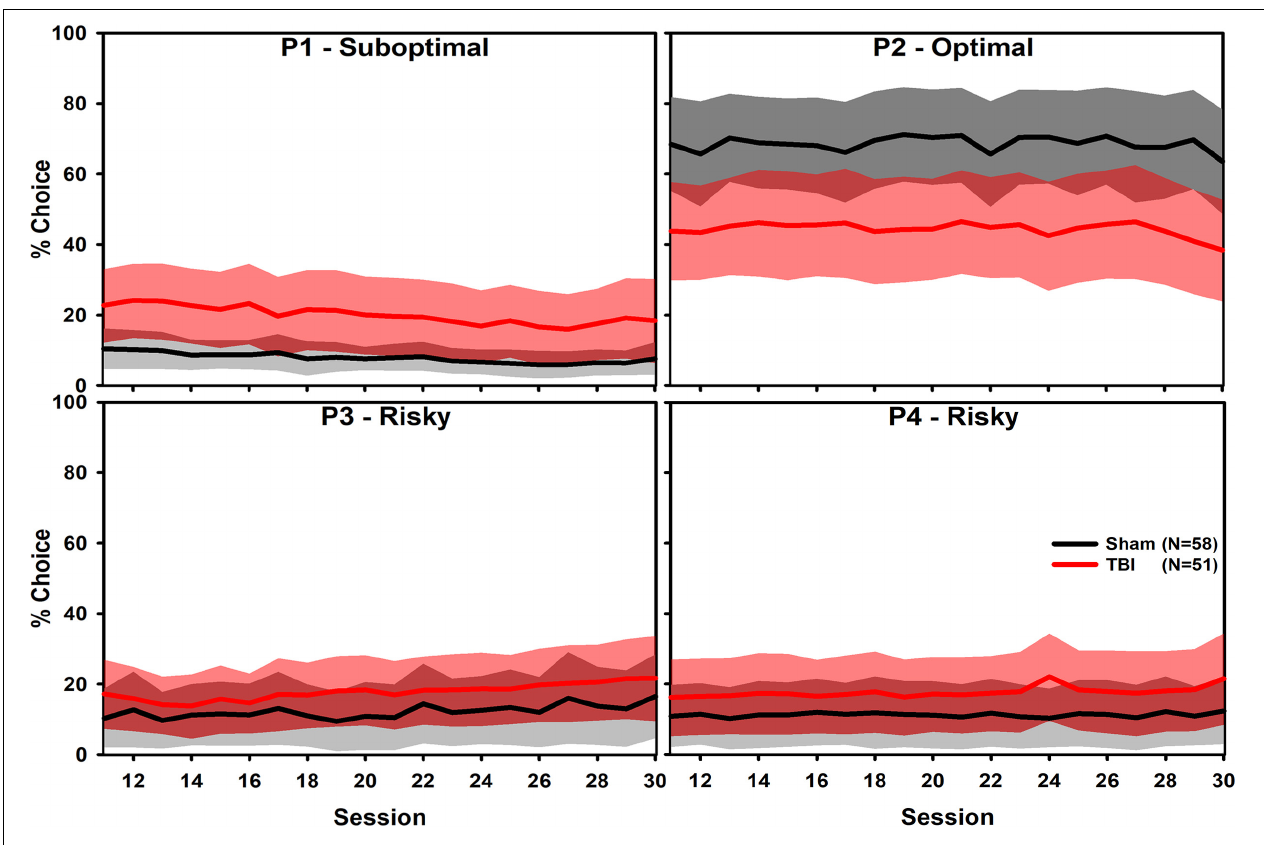
FIGURE 1 | Overall choice of the four RGT options shown as mean (solid line) and one standard deviation band (fill). Only sessions after 10 are shown to maximize visualization of stable choice preference, which represents approximately weeks 4–8 post-injury. There were significant Injury effects on each choice option (P1